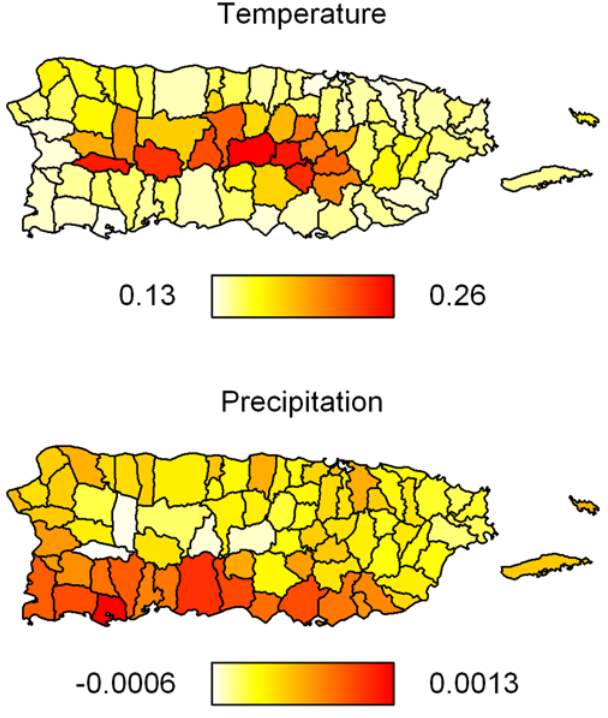
Figure 3. Spatial effects of climate on dengue incidence. Colors represent the relative strength of the cumulative association between monthly temperature and precipitation in each municipality. This is calculated as the cumulative effect of a 1 u C increase in mean monthly temperature on dengue incidence in the current and two subsequent months and of a 1 mm increase in precipitation on dengue incidence in the two following months.